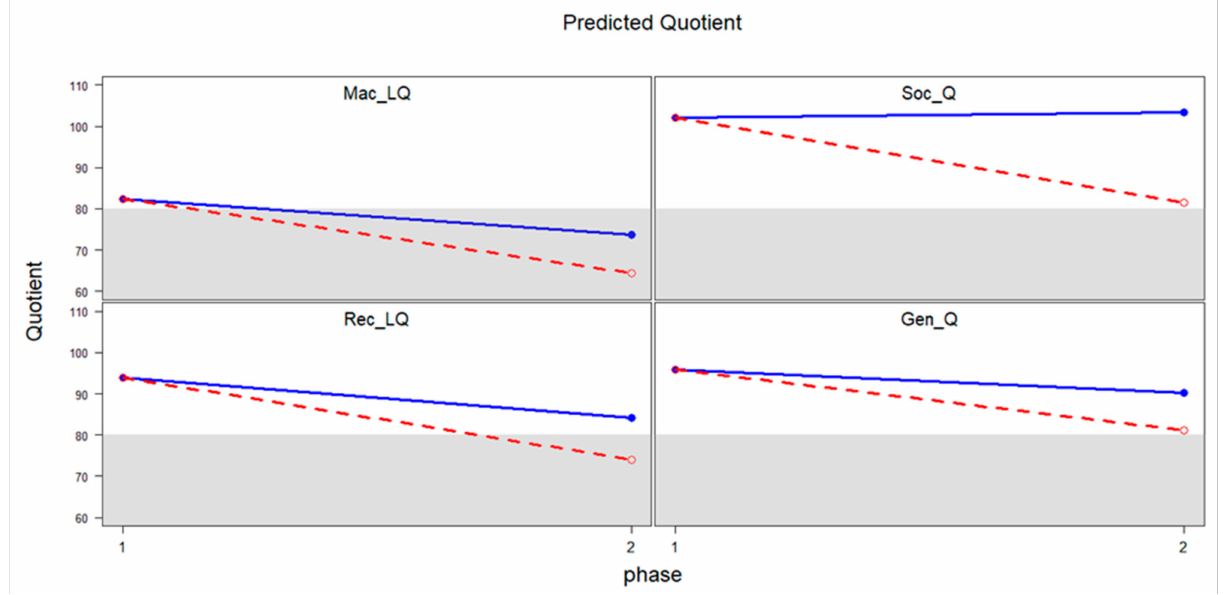
Figure 1. Predicted mean developmental quotients around 32 months of age when hearing loss was identified before and after 3 months of age. The number 1 represents the developmental quotient at Phase 1 when children were around 15 months of age, considered to be their starting point. The number 2 represents the developmental quotient at Phase 2 when children were around 32 months of age.Solid (blue) lines show the predicted mean when hearing loss was identified by three months of age, and the dashed (red) lines depict the predicted mean when hearing loss was identified after three months of age. The shaded area shows the range < 80 for quotients indicative of developmental